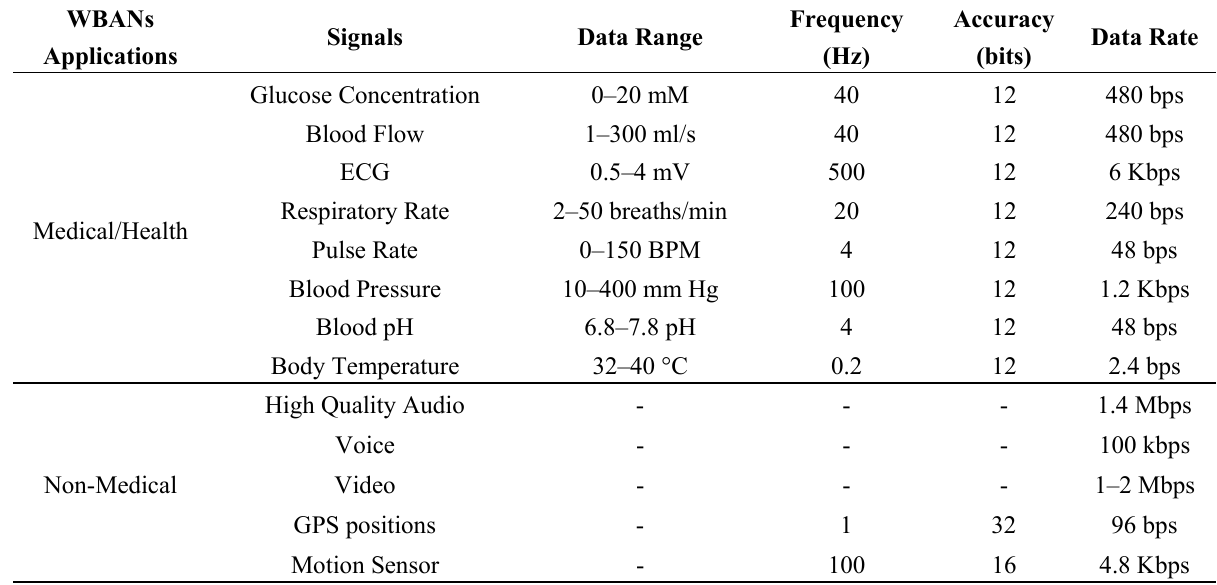
Table 2. Typical WBAN Sensors and Data